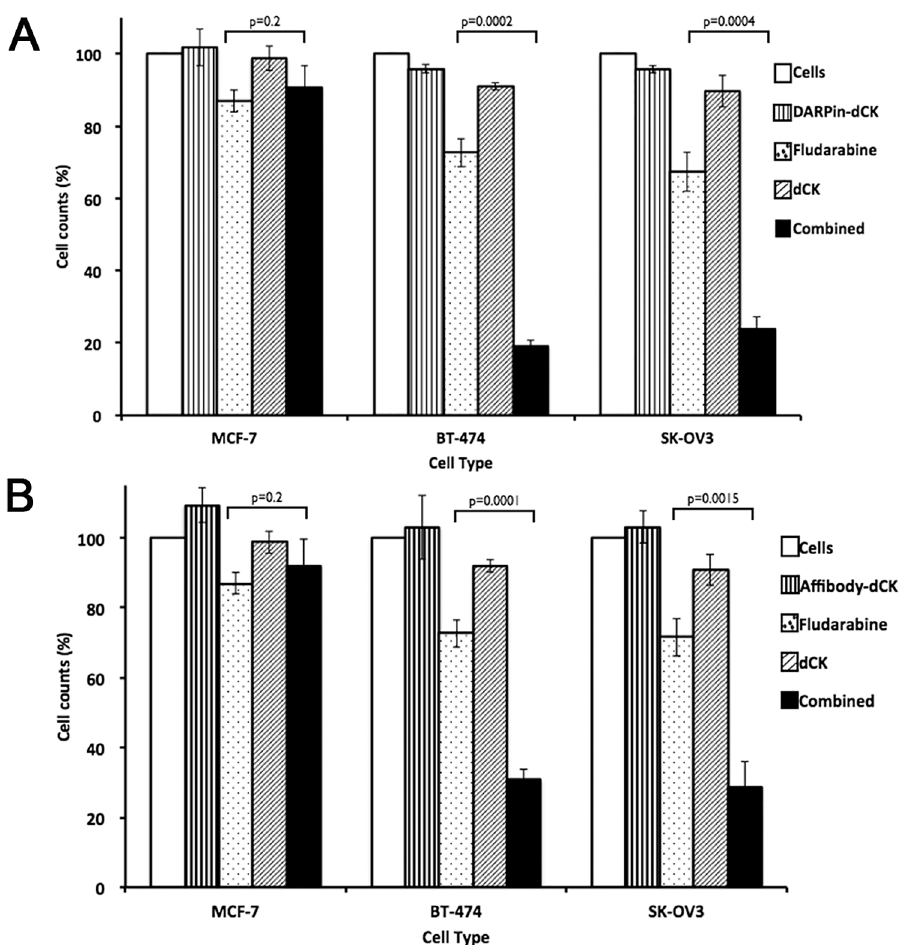
Fig 5. Effect of treatment of bi-modular fusion proteins on proliferation of cancer cells. (A) Seven thousand cells were treated with (i) buffer as control, (ii) bi-modular fusion protein (DARPin-dCK at 5 μ M, panel A or (B) Affibody-dCK at 10 μ M, panel B), (iii) fludarabine (0.25 μ M), (iv) dCK (10 μ M) and (v) as combination of fludarabine and bi-modular fusion protein at the same concentrations when tested